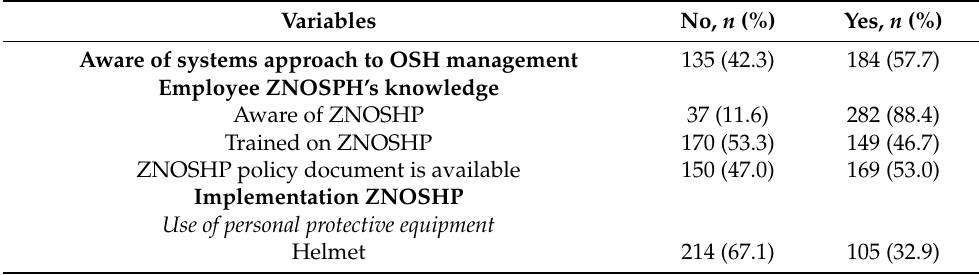
Table 1. The descriptive statistics of participant’s response on knowledge, implementation, rec- ommendations, and barriers to implementation of ZNOSHP in Willowvale industrial area, Harare, Zimbabwe ( n =